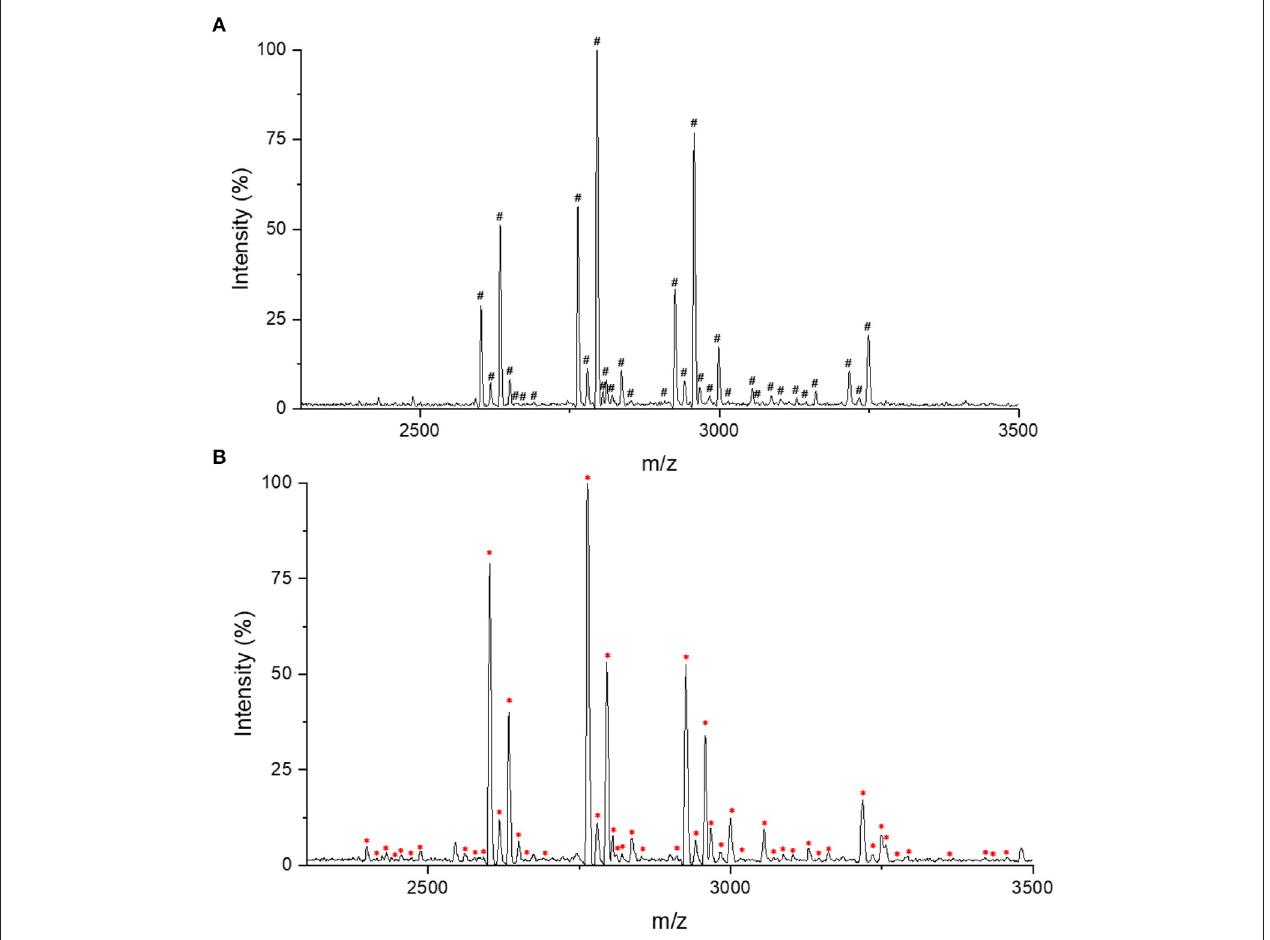
FIGURE 1 | Matrix-assisted laser desorption/ionization time-of-flight mass spectrometry (MALDI-TOF-MS) profiling in the positive-ion linear mode of enriched immunoglobulin G (IgG) N-glycopeptides. (A) The IgG N-glycopeptides enriched with chitosan@poly(glycidyl methacrylate)@iminodiacetic acid (CS@PGMA@IDA). (B) The IgG N-glycopeptides enriched with poly(glycerol methacrylate)@chitosan (PGMA@CS). # Represents the detected 33 IgG N-glycopeptides by CS@PGMA@IDA. *Represents the detected 49 IgG N-glycopeptides by